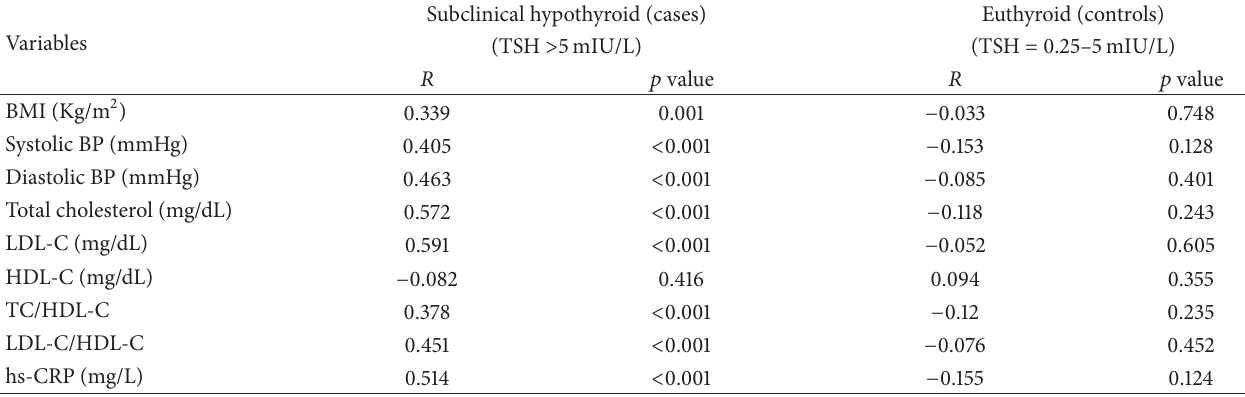
Table 2: Correlation of TSH levels of cases and controls with variables related to cardiovascular disease.